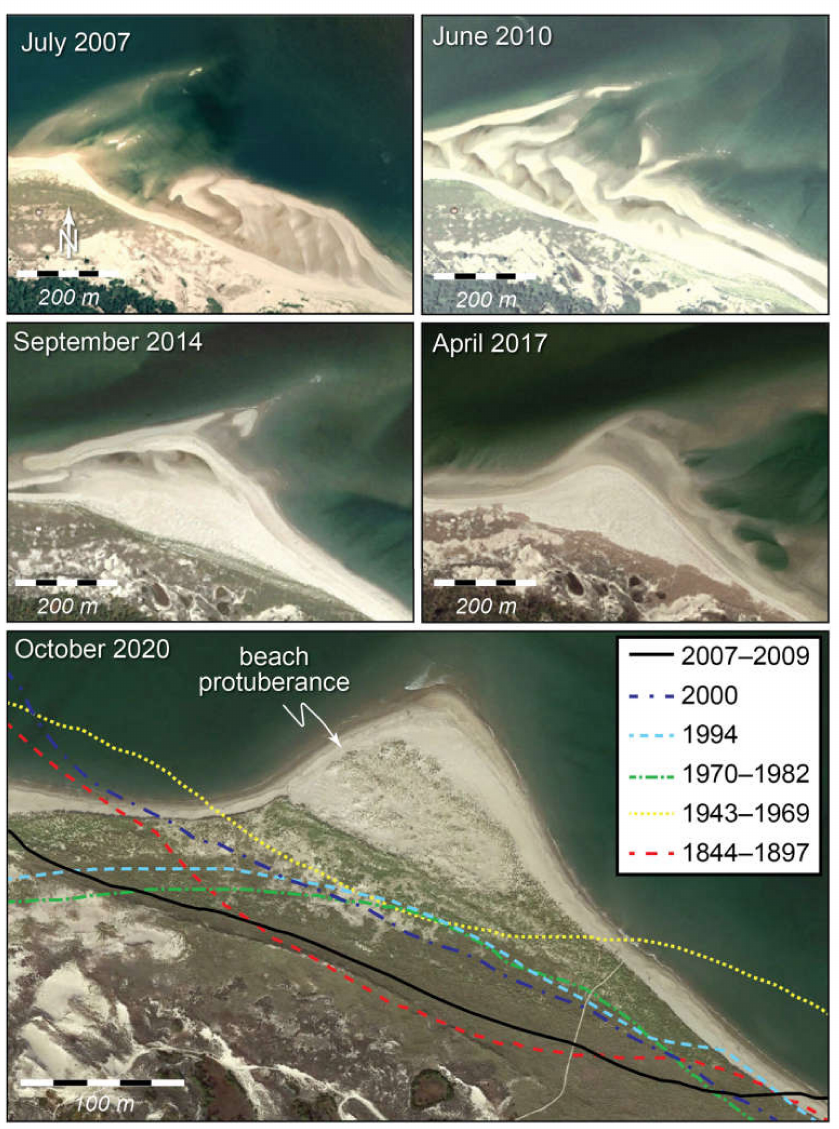
Figure 9. Sequential photographs showing development of the beach protuberance. Changes in morphology of the form is a function of where the swash have migrated onshore and attached to the beach. Bottom panel shows long-term shoreline changes. Shoreline data are from [32]. The 2007 imagery is from the USDA Farm Service Agency, and the 2010, 2014, 2017, and 2020 imagery is from